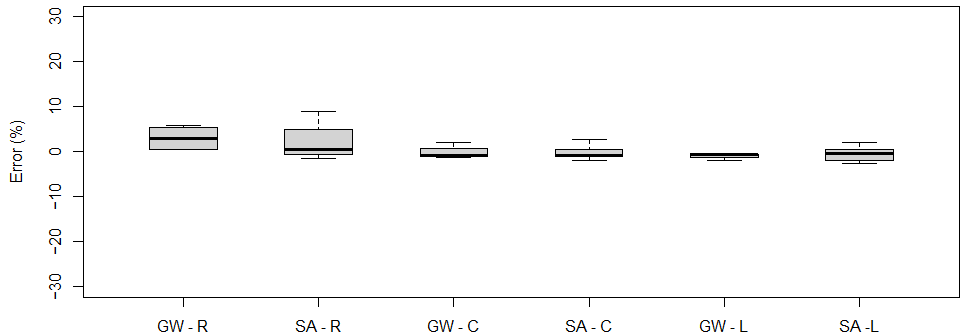
Figure 14. Measurement errors obtained for gross weight (GW), single axle (SA) for a two-axle vehicle: R—right-side run, C—central run, L—left-side run (the top and bottom of each box represent the 75th and 25th percentile values, whiskers show the minimum and maximum, the horizontal line represents median).